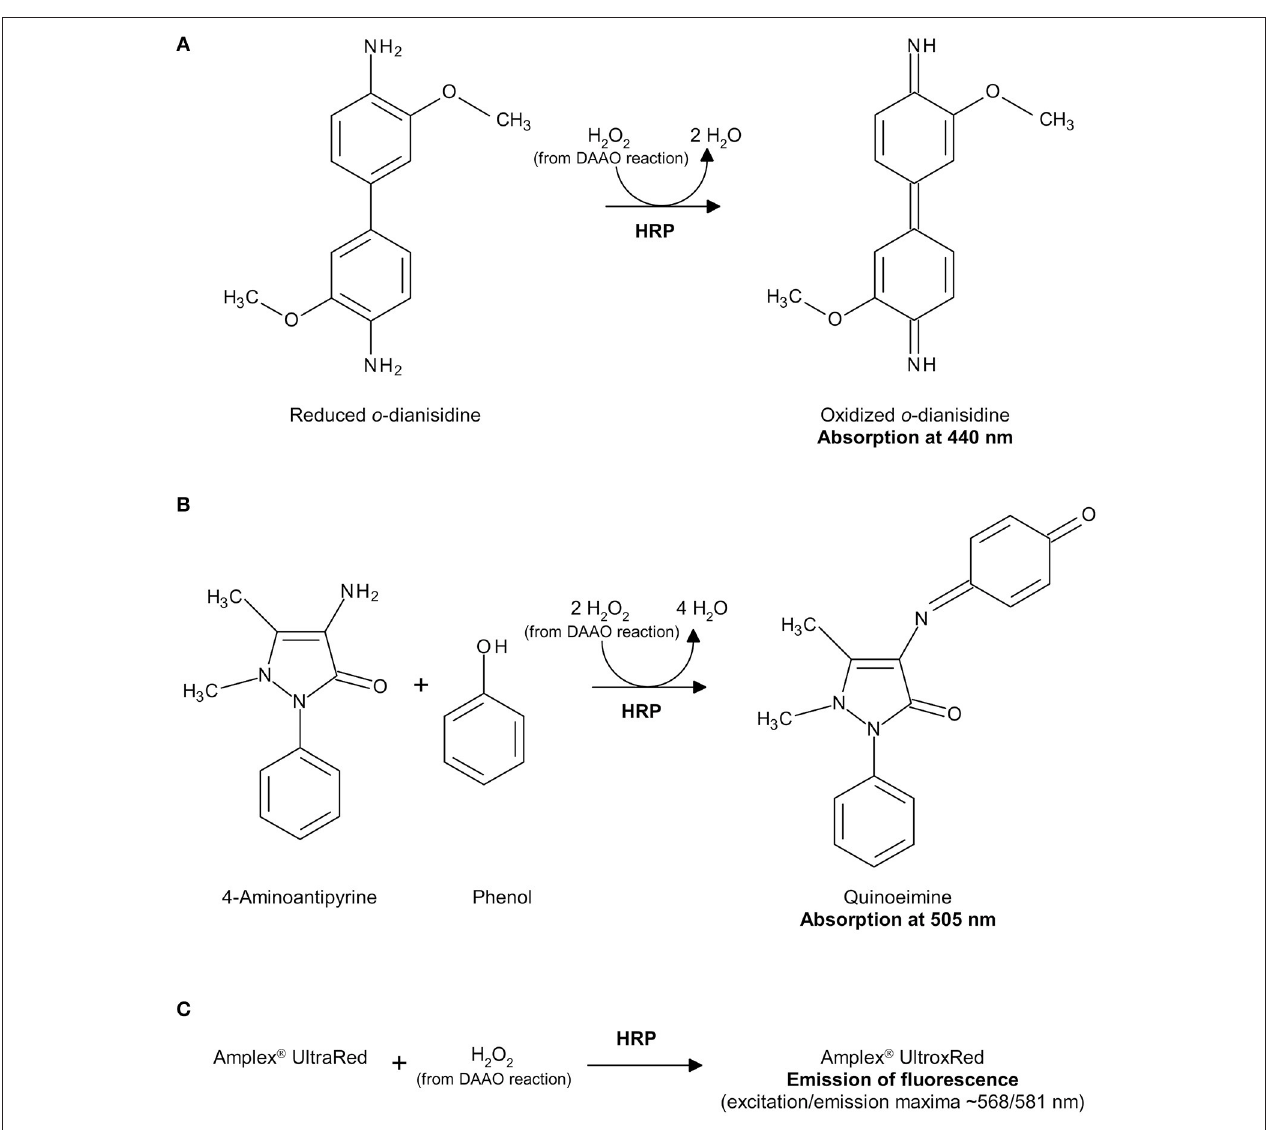
FIGURE 2 | Detection of hydrogen peroxide produced by DAAO in a HRP-coupled reaction using o -DNS (A) , 4-AAP (B) or Amplex ® UltraRed Reagent (C) .